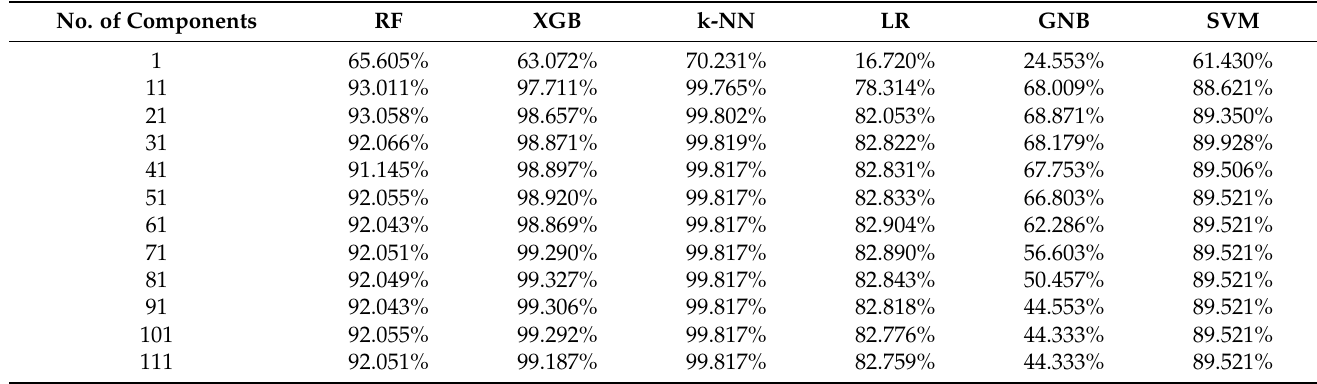
Table A2. Accuracies of Machine learning model with respect to different PCA